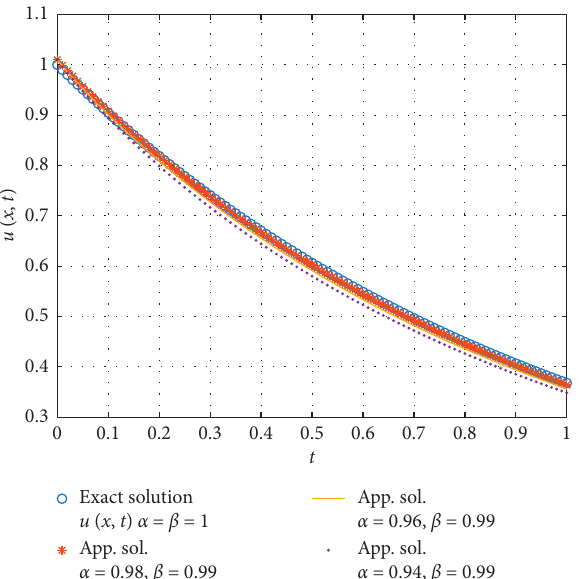
Figure 4: The exact and approximate solutions of u ( x,t ) , for Example 4, when we take different values of fractional order α and β � 0 . 99.